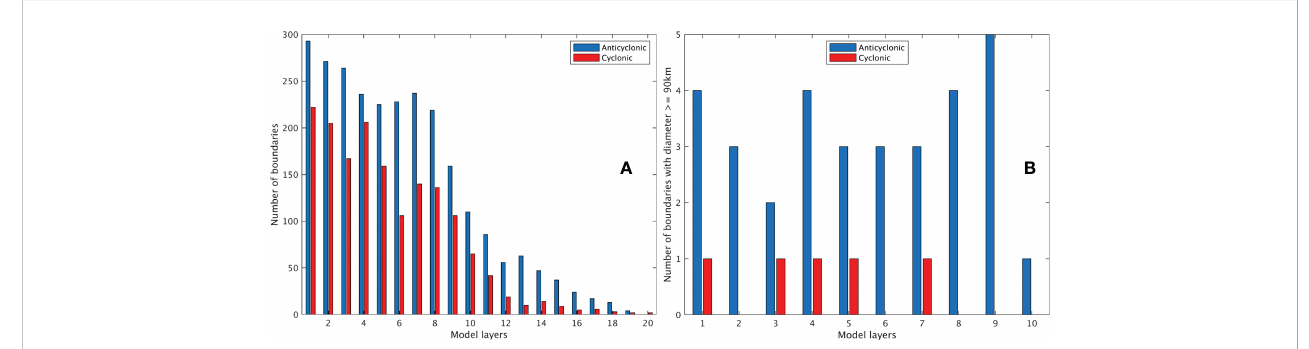
FIGURE 3 (A) Total number of anticyclonic (blue) and cyclonic (red) boundaries in each model layer (layers 1-20; ~650m), detected in the northwestern Caribbean and passed through the Yucatan Channel and (B) similar to (A) but for boundaries with diameter >= 90 km that are detected in model layers 1-10 (layer 10~=200m).